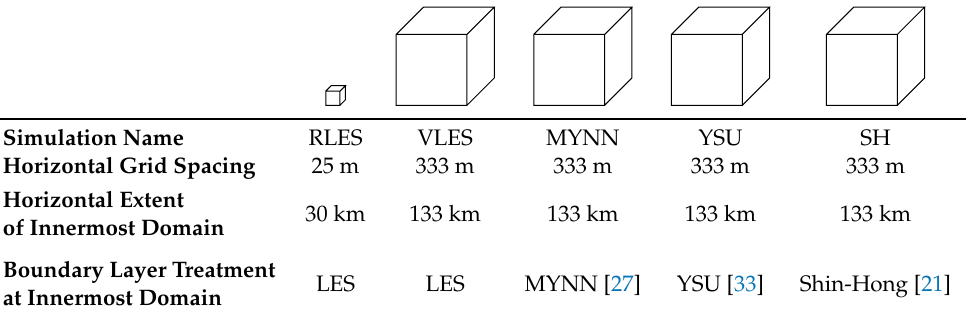
Table 1. Summary of the five simulation approaches